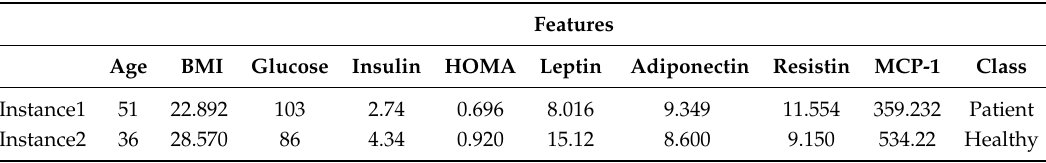
Table 3. Feature values for two persons from the Coimbra